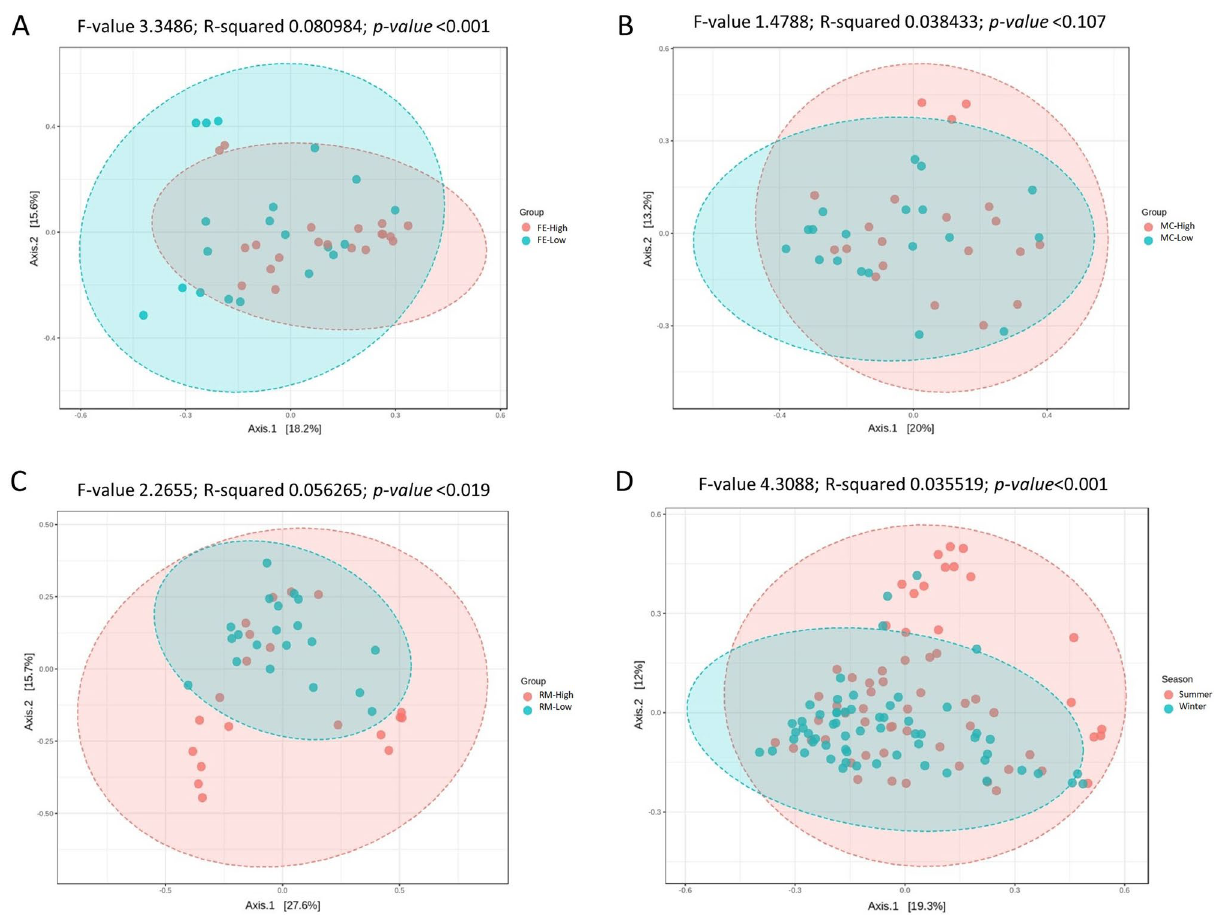
Figure 2. Principal coordinate analysis (PCoA) based on Bray–Curtis distance metrics and permutational multivariate analysis of variance (PERMANOVA) to indicate the beta diversity among different groups. ( A )